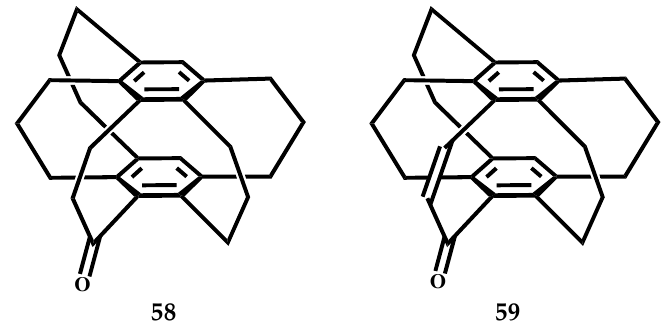
Figure 27. The structures of [3 5 ](1,2,3,4,5)CP-1-one 58 and 59 .